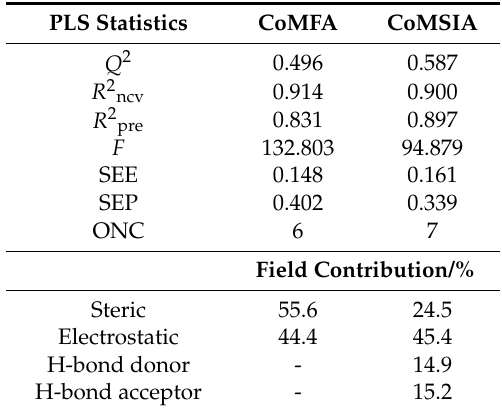
Table 3. Summary of 3D-QSAR